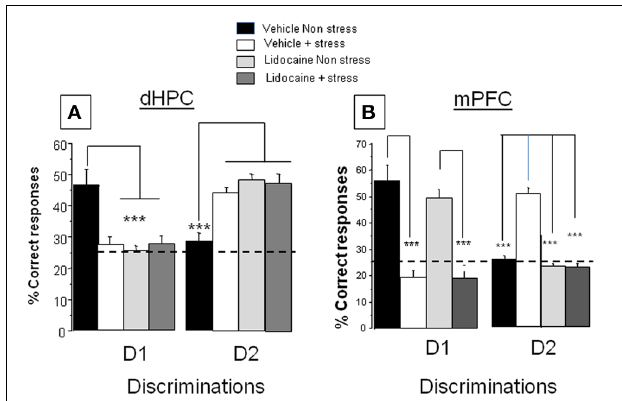
FIGURE 2 | Effects of lidocaine injections into the dHPC and mPFC on memory patterns in the CSD task in non-stress and stress conditions. (A) dHPC. Discrimination 1, D1 Left : Percentage of correct responses in vehicle and lidocaine-injected mice in non-stress and stress conditions. Lidocaine was injected 15min before stress delivery (which occurred 15min before test) thus 30min before behavioral testing. Stress and lidocaine induced a significant decrease of the % of correct responses ( ∗∗∗ p < 0 . 001 vs. Vehicle non-stress). (A) Discrimination 2, D2 right : Percentage of correct responses in vehicle and lidocaine-injected mice in non-stress and stress conditions. Stress and lidocaine induced a significant increase of the % of correct responses ( ∗∗∗ p < 0 . 001 vs. Vehicle non-stress); (B) mPFC: Discrimination 1, D1: Left : Percentage of correct responses in vehicle and lidocaine-injected mice in non-stress and stress conditions. Stress significantly decreased the % of correct responses ( ∗∗∗ p < 0 . 001 vs. Vehicle non-stress); in contrast, lidocaine had no effect in non-stress condition as compared the Vehicle non-stress group (NS) and lidocaine did not blocked the deleterious effect of stress on performance (Lidocaine+stress vs. Lidocaine non-stress; ∗∗∗ p < 0 . 001). Discrimination 2, D2: right: Percentage of correct responses in vehicle and lidocaine-injected mice in non-stress and stress conditions. Stress induced a significant increase of the % of correct responses ( ∗∗∗ p < 0 . 001 vs. Vehicle non-stress). Lidocaine blocked the stress-induced increase of the % of correct responses ( ∗∗∗ p < 0 . 001 vs. Vehicle + stress).